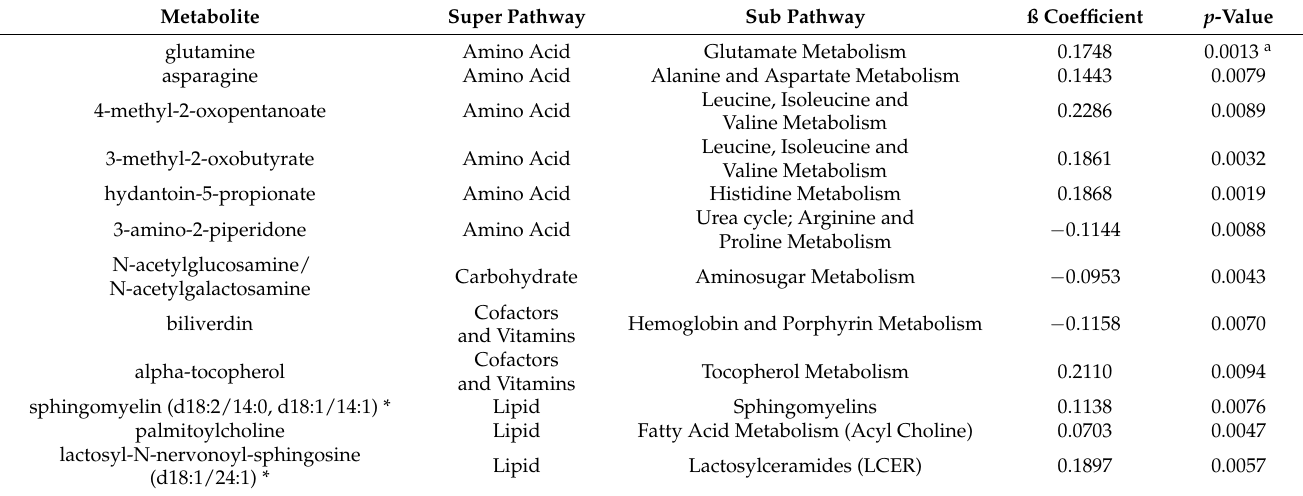
Table 6. Changes in metabolites at 3 years and associations with changes in area under the dark adaptation curve ( p <